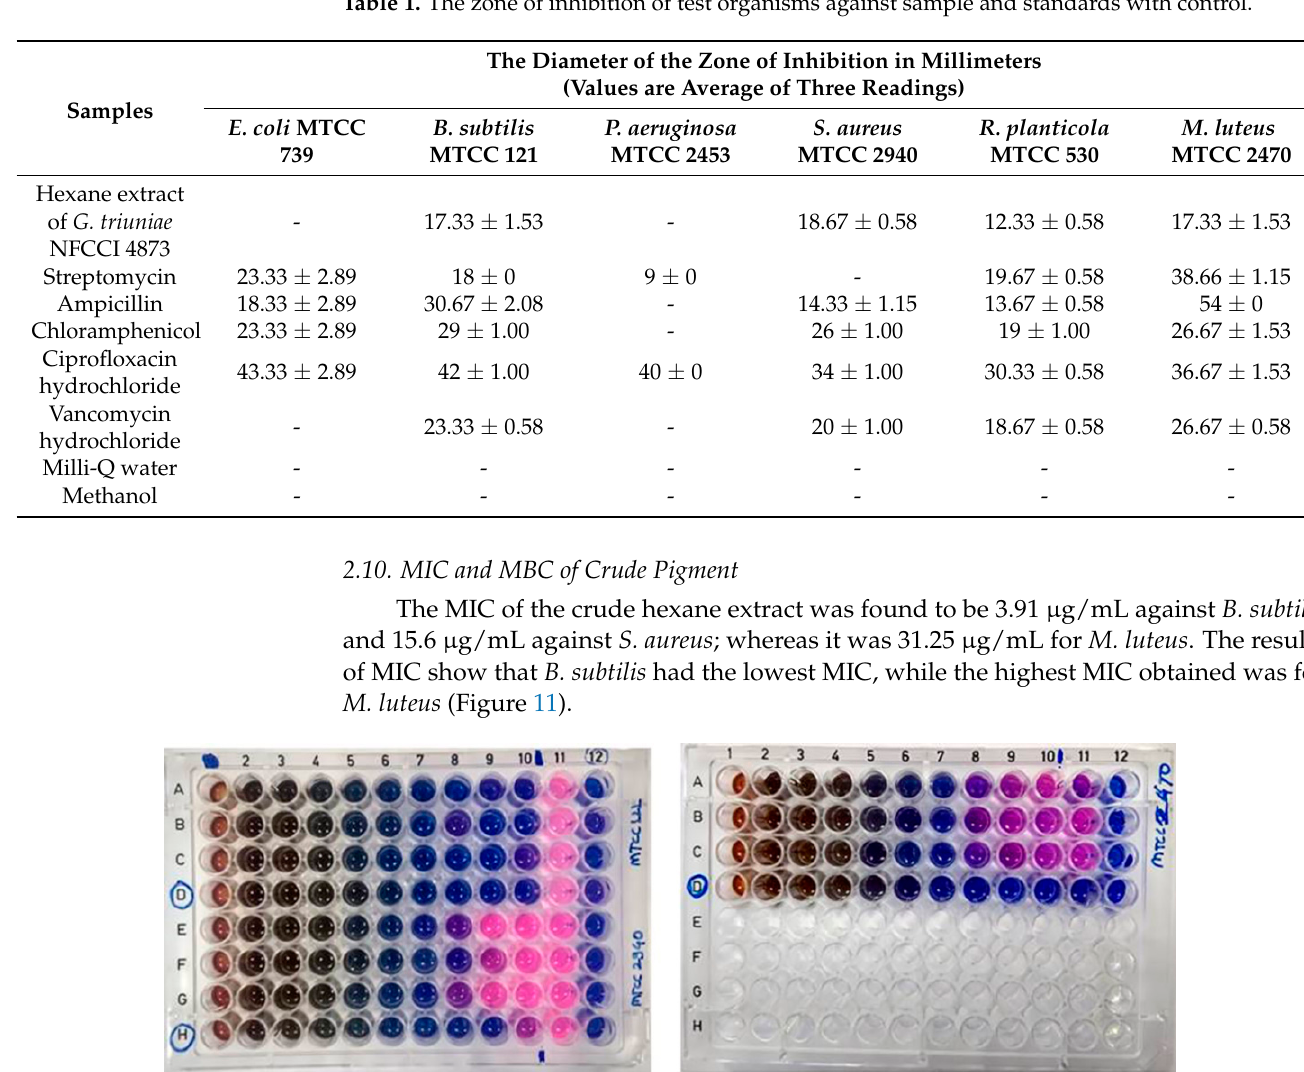
Table 1. The zone of inhibition of test organisms against sample and standards with control.